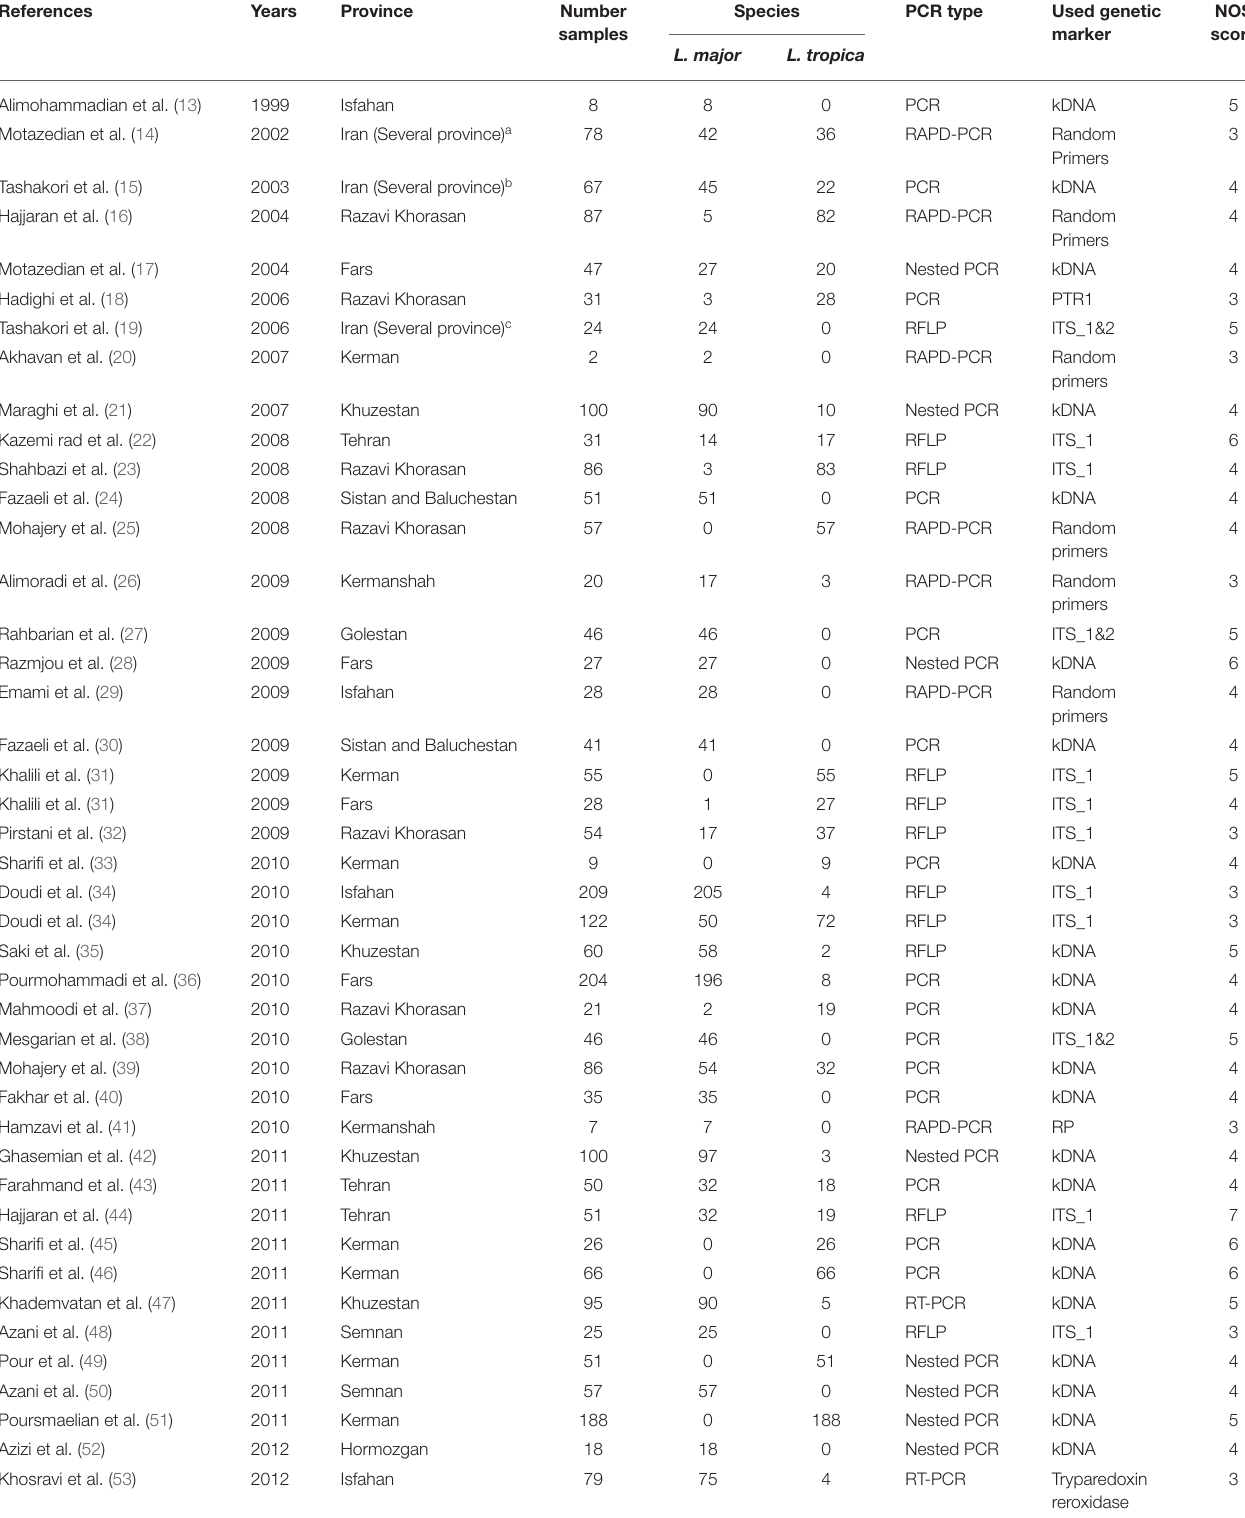
TABLE 1 | Baseline characteristics of the Leishmania species identification from CL cases in the systematic review and meta-analysis from 1999 to